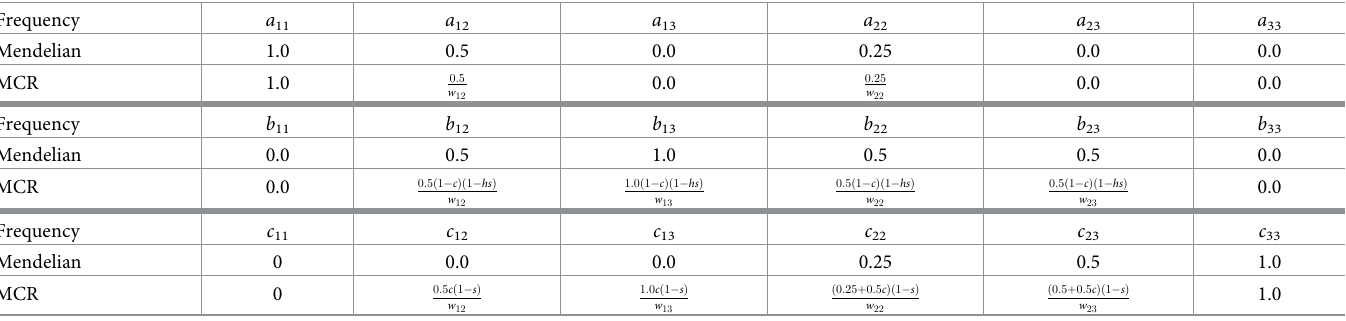
Table 4. Genotypic frequencies for both Mendelian and MCR